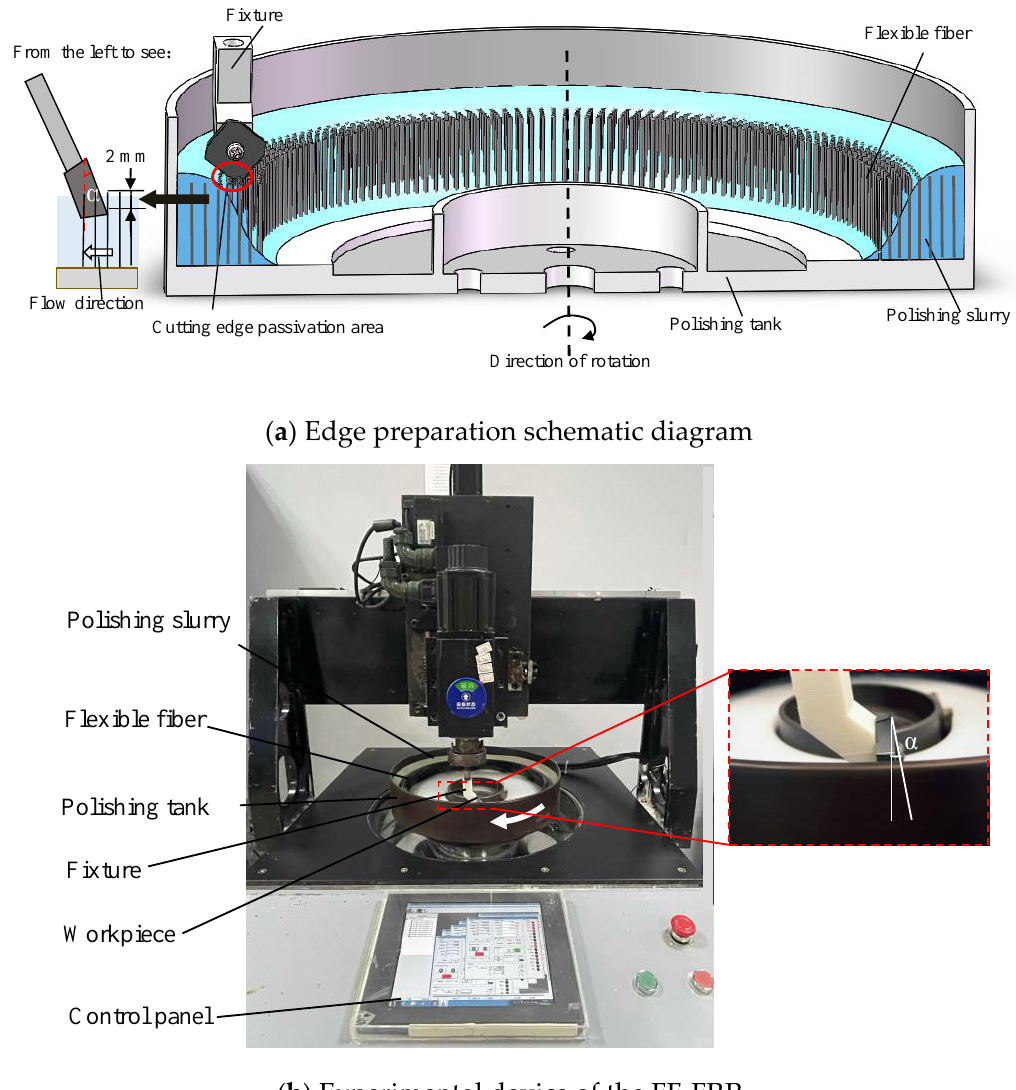
Figure 2. The FF-FRP experimental device ( a ) Schematic illustration. ( b ) Picture of experimental device.